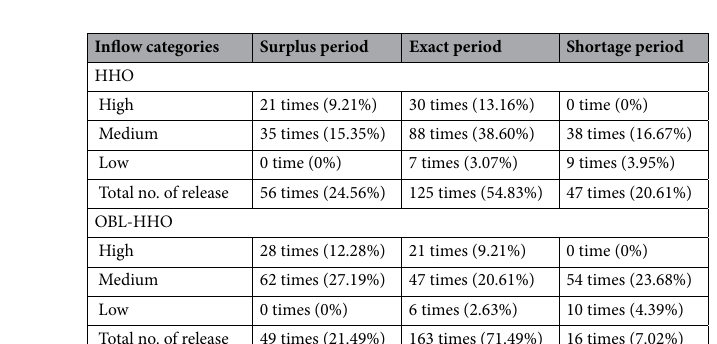
Table 3. Periodic reliability performance of the HHO model from the year 2001–2019.